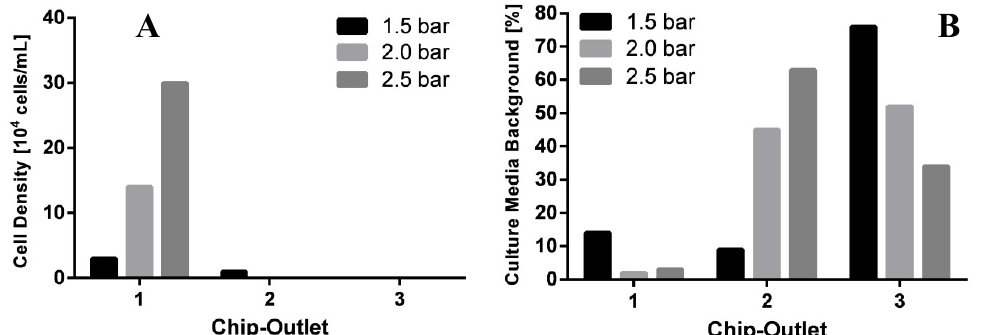
Figure 3. ( A ): Effects of overpressure on the distribution of Chinese Hamster Ovary cells (CHO-K1) cells at the chip outlets 1, 2 and 3 after passing the spiral separator. ( B ): Distribution of extracellular medium (as measure of glucose concentration) depending on overpressure at chip Outlets 1, 2 and 3 after passing the spiral